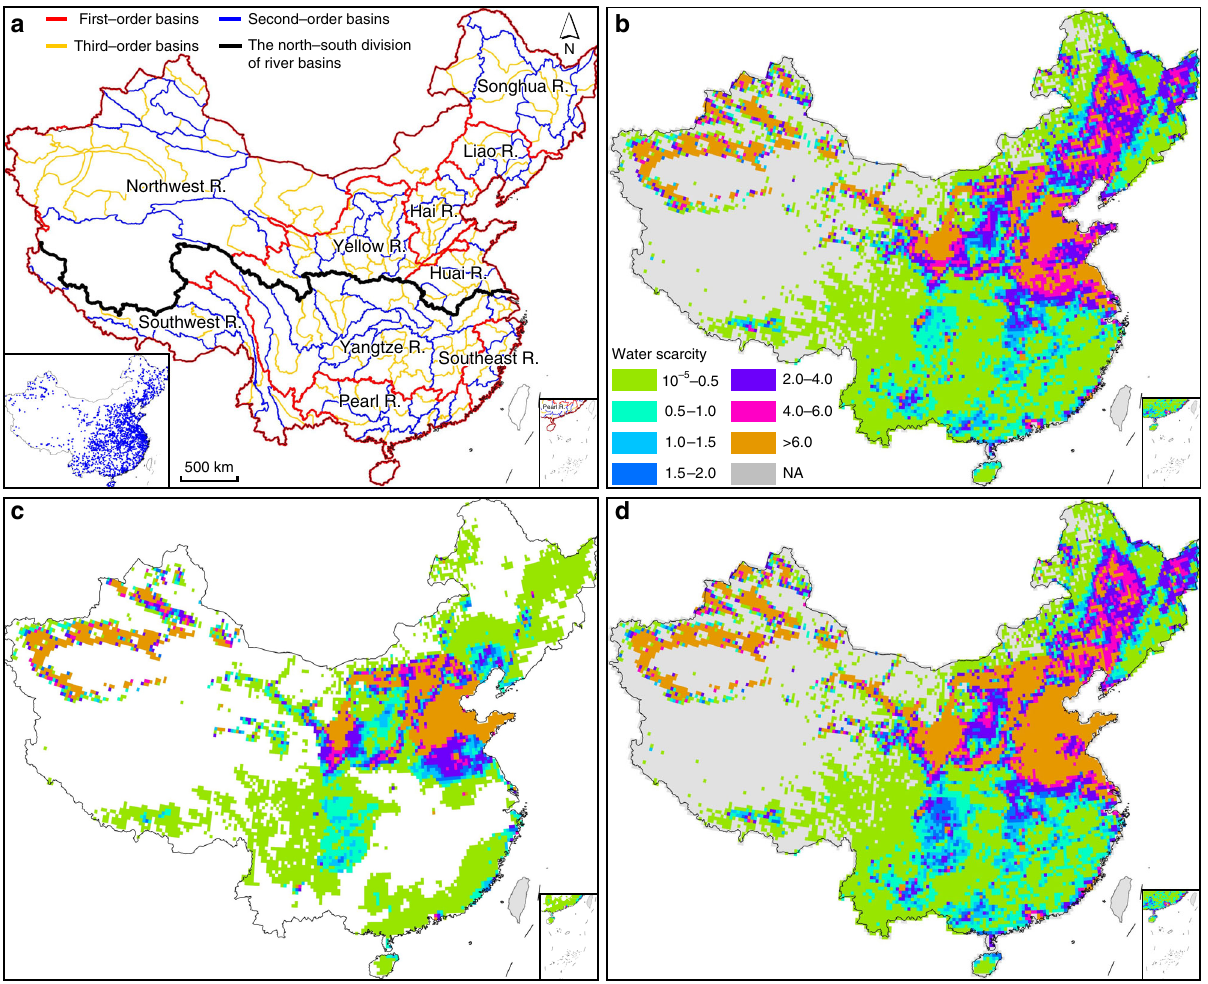
Fig. 1 Estimates of annual water scarcity at the grid cell level in China. a Spatial distributions of river basins in this study. b Quantity-based water scarcity (WSqua). c Pollution-induced water scarcity (WSpol). d Combined water scarcity, including both quality and quantity effects (WScom). Estimated water scarcity was based on the average of annual assessments during 2012 – 2016 at a spatial resolution of 0.25 × 0.25 arc-degree ( n = 15997). The graph at the lower left corner in a represents the sampling locations of water quality. Maps of grid cell-level WScom at other time scales are shown in Supplementary Fig. 2. NA, no data or water scarcity is <10 − 5 . Source data are provided as a Source Data fi le.